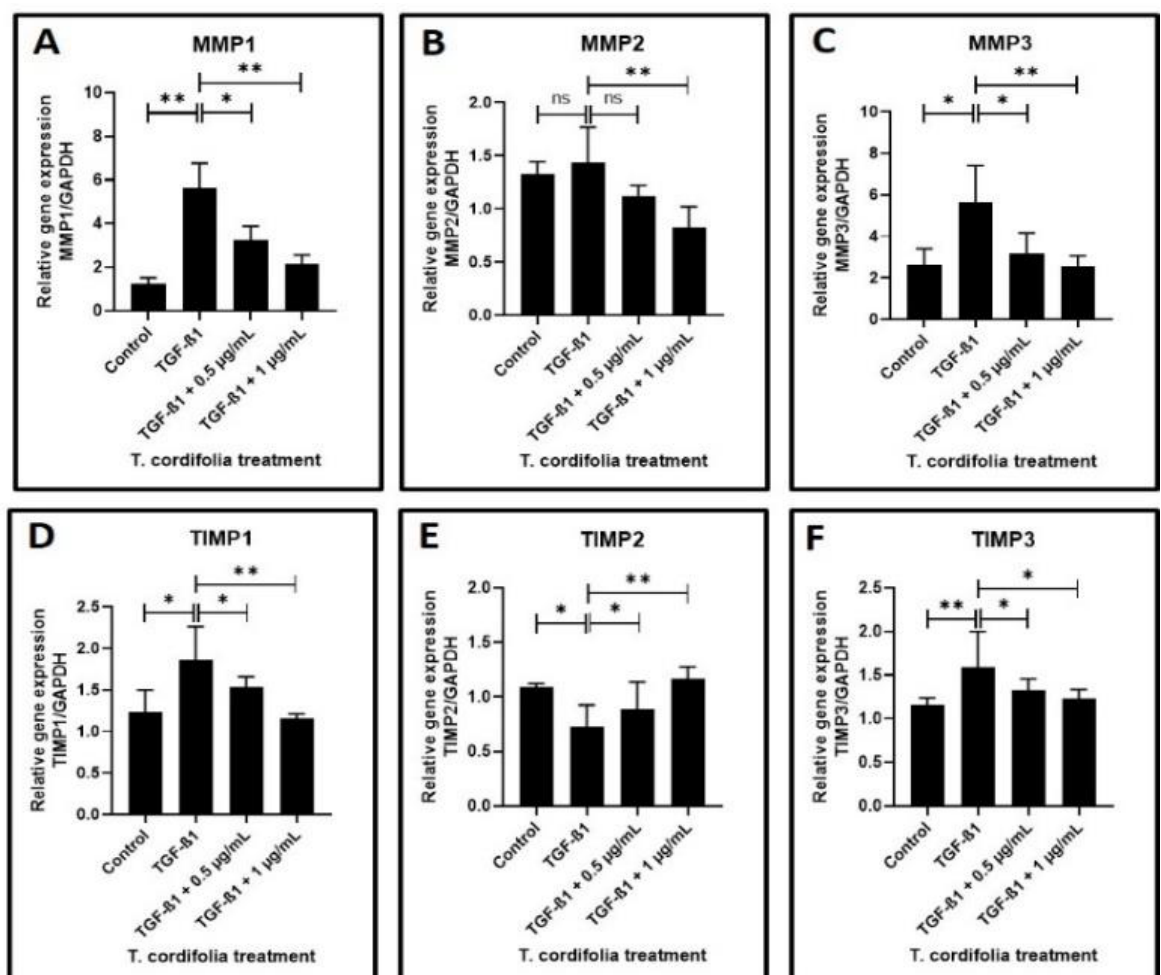
Figure 3. Analysis of gene expression by quantitative RT-PCR. ( A – C ) Fibrosis was induced by TGF-β1 in the oral keratinocytes and comparative gene expression analysis was carried out in the fibrosis-induced oral keratinocytes treated with various concentrations of TcE for matrix metalloproteinase-related gene expression for MMP1, MMP2, and MMP3. ( D – F ) Fibrosis was induced by TGF-β1 in the oral keratinocytes and comparative gene expression analysis was carried out in the fibrosis-induced oral keratinocytes treated with various concentrations of TcE for matrix-metallo- proteinase inhibitor-related gene expression for TIMP1, TIMP2, and TIMP3. ns—not significant, *